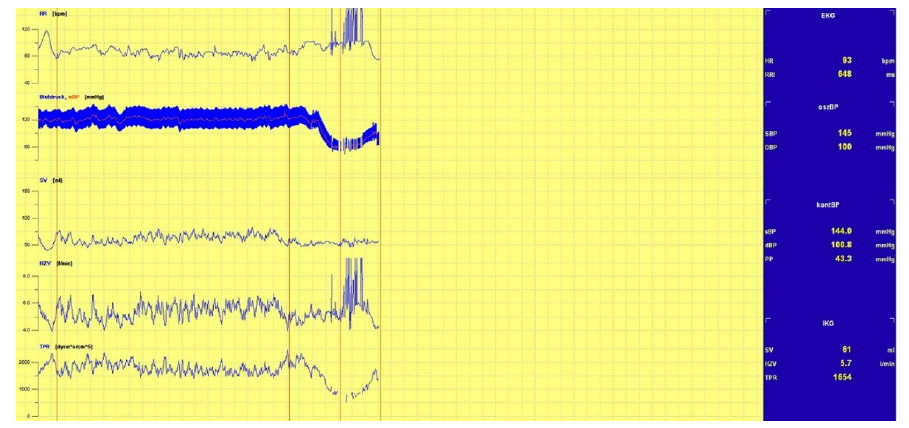
Figure 2. Drop in BP.